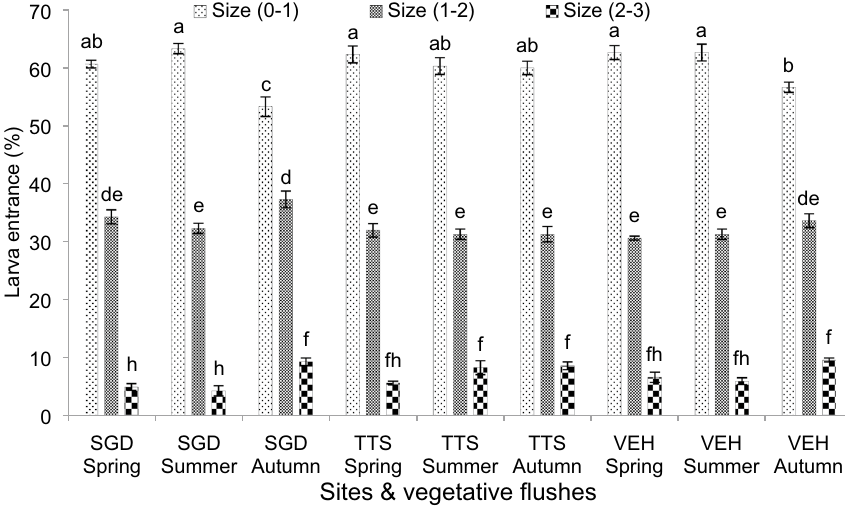
Figure 3. Larva entrance after egg-hatching of leaf size. Bars sharing dissimilar letters are significantly differed according to LSD test ( P ≤ 0.05).Leaf size in cm 2 .